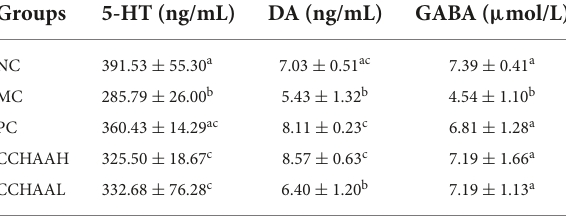
Different letters in the same column of data indicate significant differences between groups( p < 0.05). TABLE 3 The effects on neurotransmitter secretion in the brain tissue ( n = 12). Groups